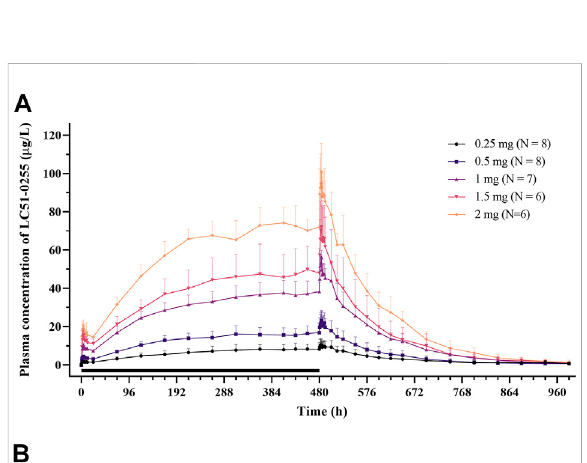
FIGURE 5 Mean plasma concentration – time pro fi les of LC51-0255 in (A) linearscaleand (B) loglinearscaleafterdailyoraladministration of0.25,0.5,1,1.5,and2 mgofLC51-0255for 21 days.Notes: Error barsdenotethestandarddeviations.Theblackbarrepresents the duration of treatment.